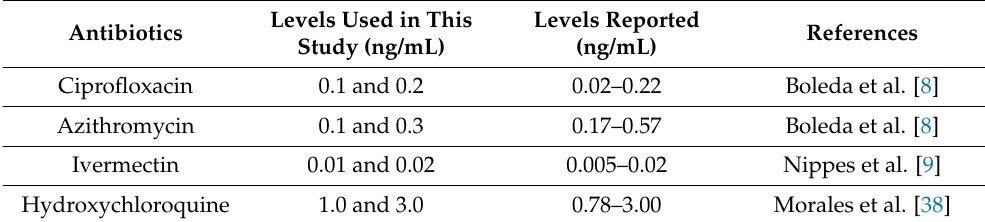
Table 3. Selection of levels according to other research works. Levels Used in This Levels Antibiotics Study (ng/mL)